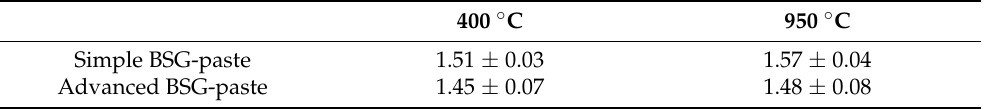
Figure 2. Spectroscopic analysis of obtained thin films. ( a ) Refractive index n as a function of the maximum temperature T max during thermal treatment; ( b ) absorbance A of differently treated films as a function of wavenumber υ indicating the presence of characteristic atomic bonds in the films. Table 1. Refractive indices n obtained for two different pastes after thermal treatment at two different temperatures. The given uncertainties are statistical only.